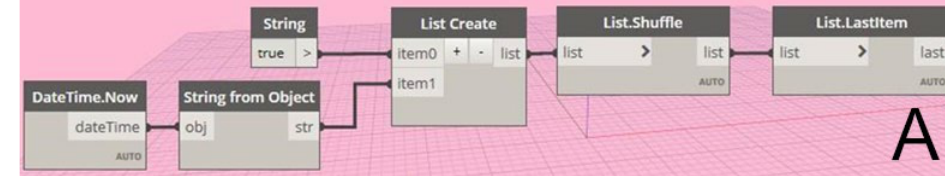
Figure 8. Switch block of